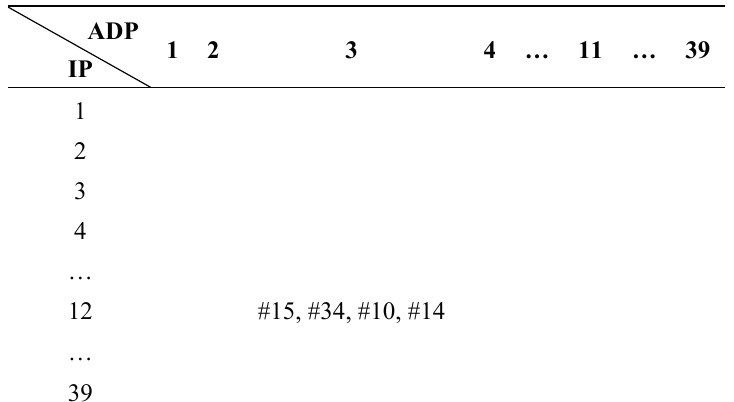
Table 1. Partial cells of the contradiction matrix. ADP, avoiding degradation parameters; IP, improving